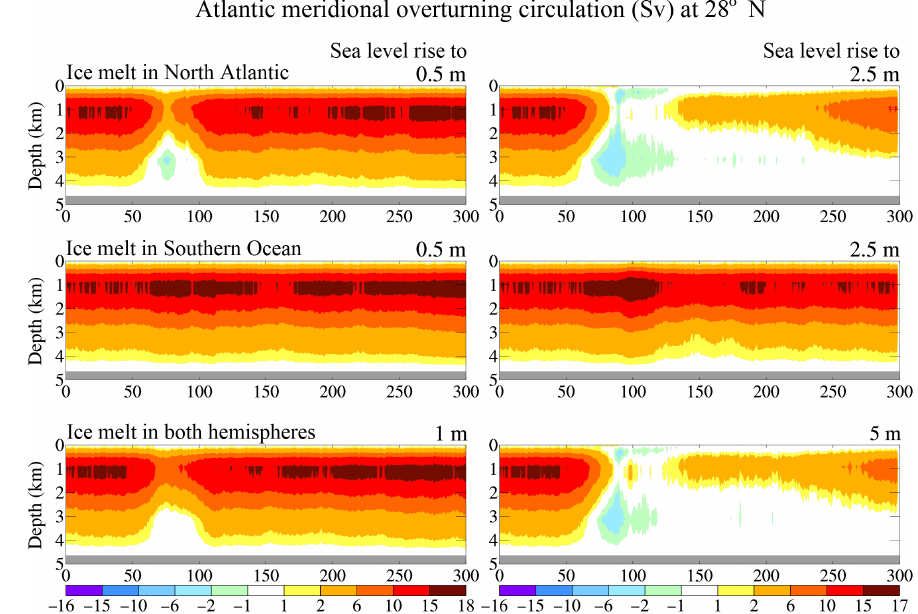
Figure 10. Ensemble-mean AMOC (Sv) at 28 ◦ N versus time for six pure freshwater forcing